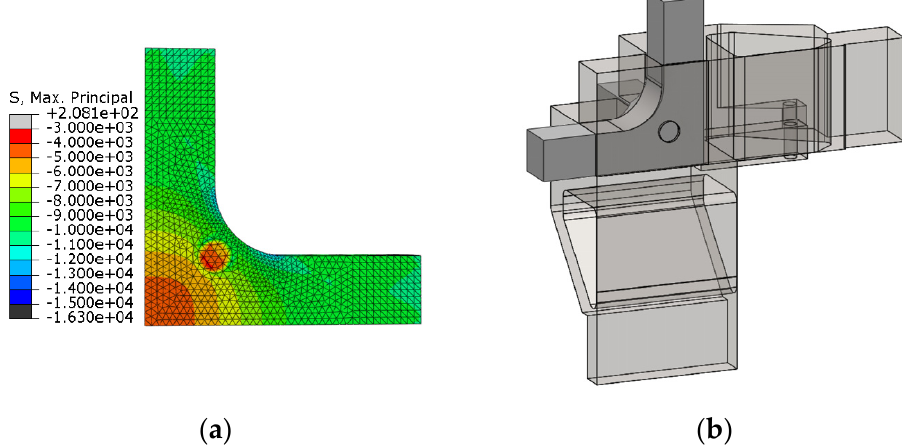
Figure 14. In geometry A for the CCC loading case: ( a ) Maximum principal stress field with an opening with r = 2.5 mm and d = 10 mm; ( b ) sketch of the fixture with a cut for visualizing the position and diameter of the opening.